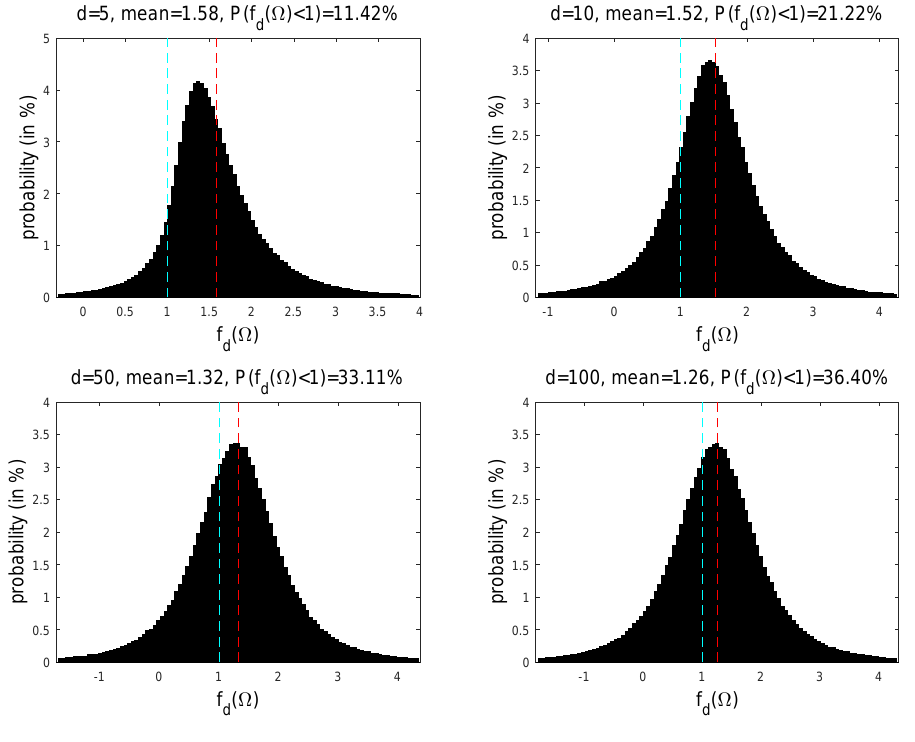
Figure 3: Histogram of the probability distribution of f d ( Ω ) with Ω ∼ U ( C d ) based on n = 1, 000, 000 simulations, for d ∈ { 5, 10, 50, 100 } . The vertical, red line gives the mean, and the blue line represents the border 1 between over- and un- derrepresentation of the